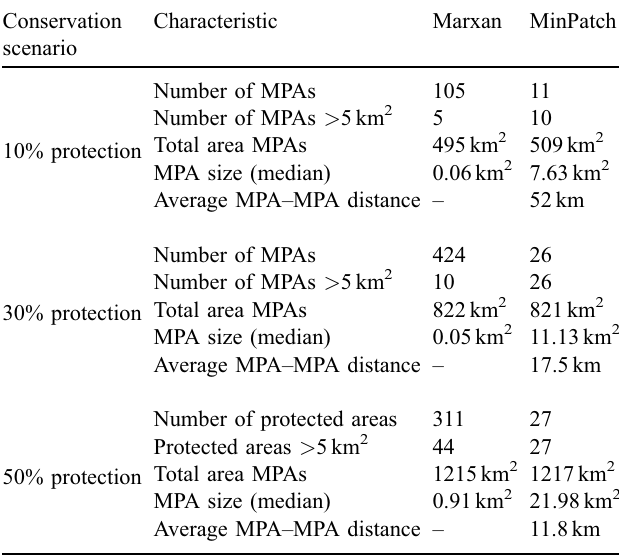
Table 2. Summary of the Marxan and MinPatch runs for the three conservation scenarios. Average distance represents the average of the distances between two neighboring MPAs. It was not estimated for the Marxan solutions given the high number of MPAs and small distances between